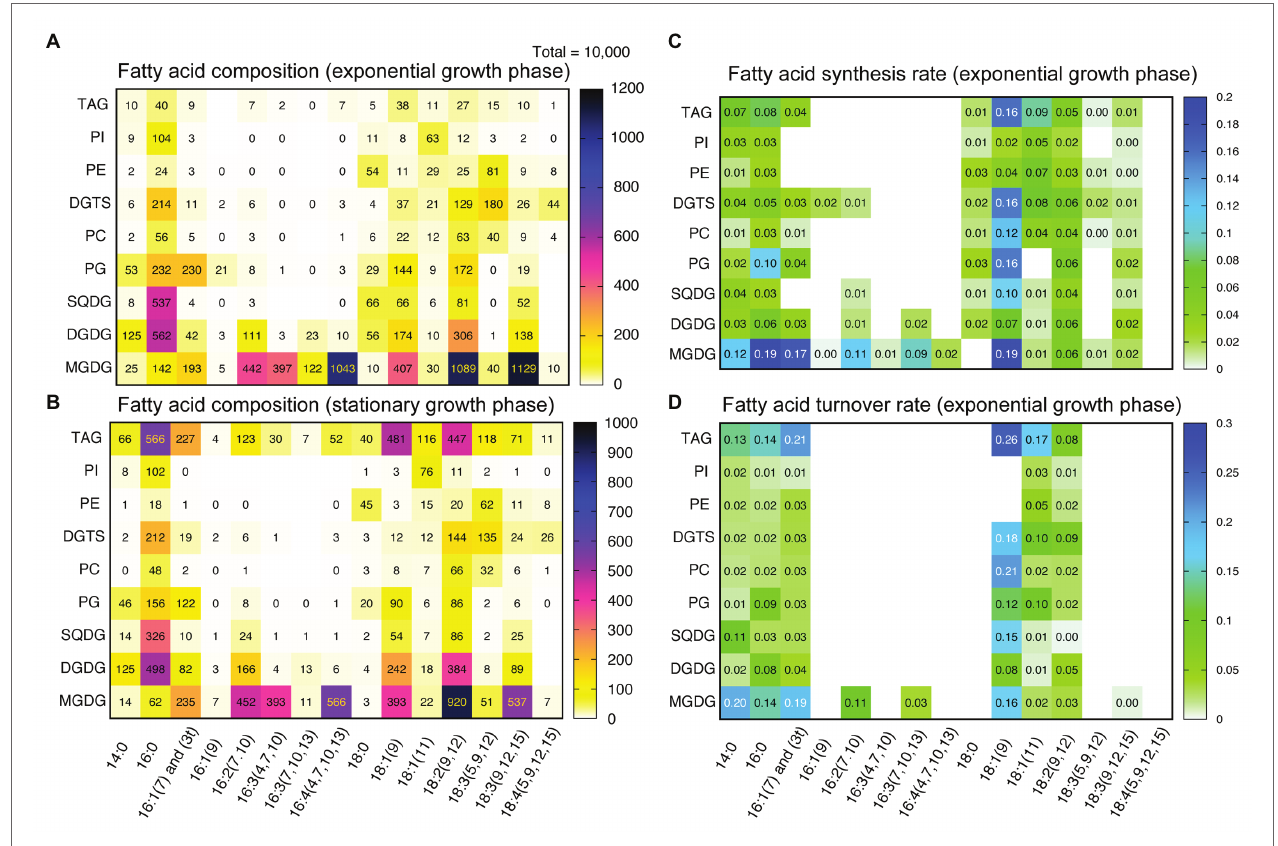
FIGURE 4 | Fatty acid composition and fatty acid turnover rates in individual lipid classes. (A) Fatty acid composition of lipid classes in the exponential growth phase (48 h). (B) Fatty acid composition of lipid classes in the stationary growth phase (144 h). (C) Fatty acid synthesis rates of individual lipid classes. The rates (in h −1 ) were calculated for the data of 2-h labeling and 5-h labeling with [ 13 C]bicarbonate according to Supplementary Material and averaged. (D) Fatty acid turnover rates of individual lipid classes calculated for the chase data after the labeling with [ 13 C]bicarbonate according to Supplementary Material . In (A,B) contents of fatty acids are normalized by setting the amount of total fatty acids (of all lipid classes) to